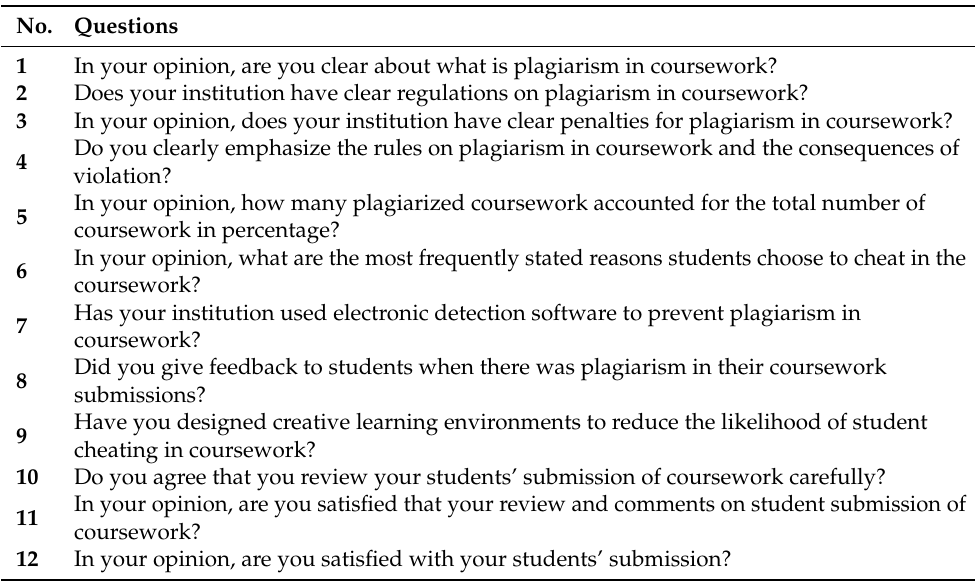
Table 2. Main questionnaire for